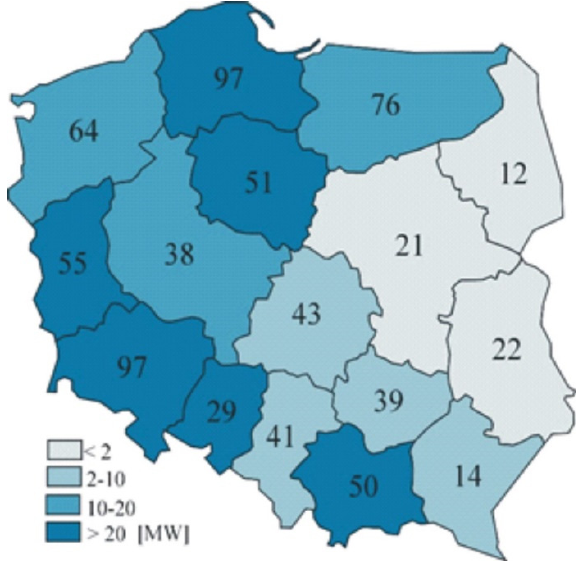
Figure 3. Number and power of water energy plants in Poland (own elaboration from [50]).